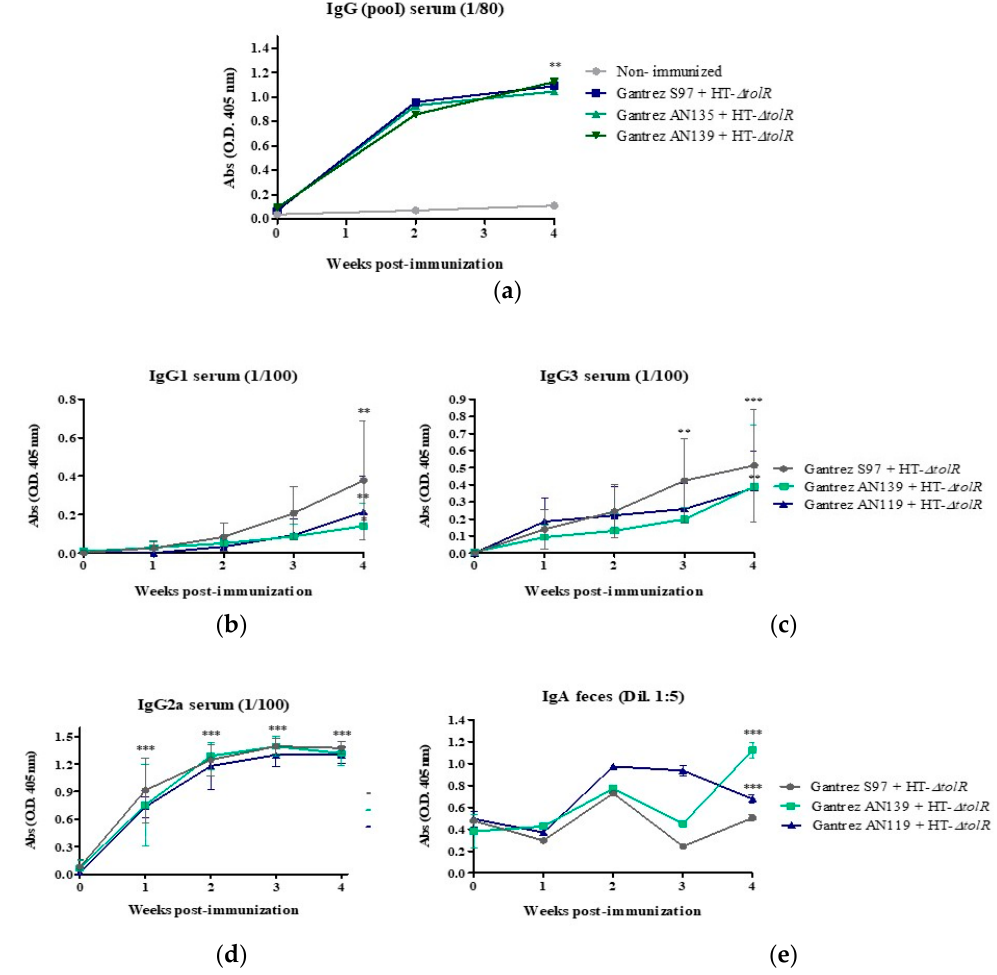
Figure 5. Antibody immune response induced after skin vaccination of mice with HT- Δ tolR or embedded in Gantrez ® AN119 microneedles. Specific serum IgG ( a ), IgG1 ( b ), IgG3 ( c ), and Ig2a ( d ) levels against HT- Δ tolR , as well as IgA ( e ) levels in feces of immunized BALB/c mice. Blood and fecal samples were taken from weeks 0 to week 4 after immunization (**, p < 0.01, ***, p < 0.01 versus time 0). Error bars represent SD ( n = 6).